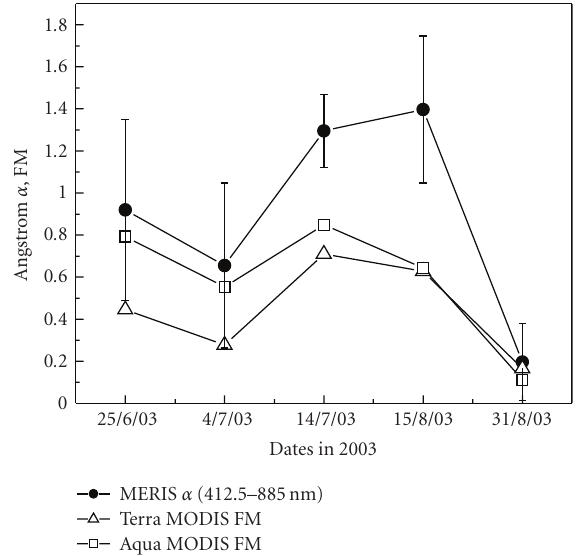
Figure 5: Mean daily ˚Angstr¨om exponent α values derived from MERIS in the 412.5–885 spectral band. The vertical bars express one standard deviation from the spatially averaged MERIS α value. The fine mode fraction values derived from both Terra/Aqua MODIS sensor over Athens are also shown.